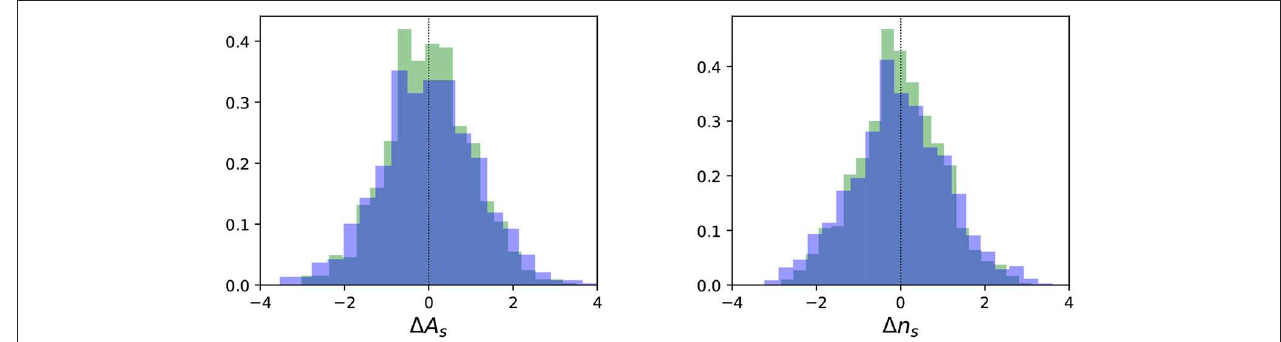
FIGURE 3 | Histograms of the biases for the parameters expectation values estimated from the power spectra of 1000 simulated full-sky maps of CMB temperature and polarization, plus white isotropic noise. Biases are defined with respect to the input parameter values and normalized to the 1 σ uncertainty on the parameter,